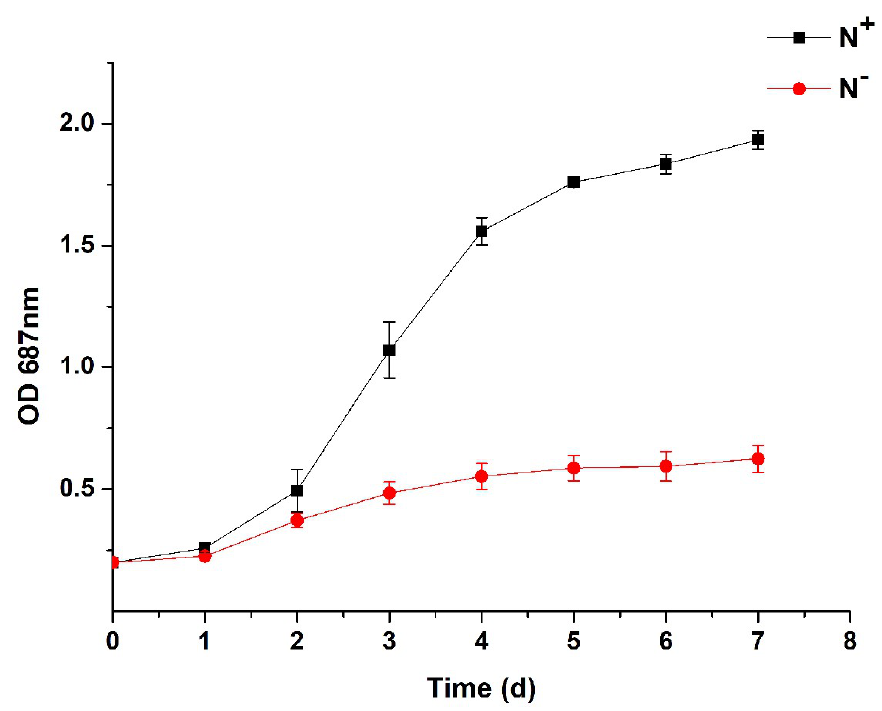
Figure 1. Absorbance comparison between N + and N − of Parachlorella kessleri TY02. Data are shown as mean ± SE. n = 3.